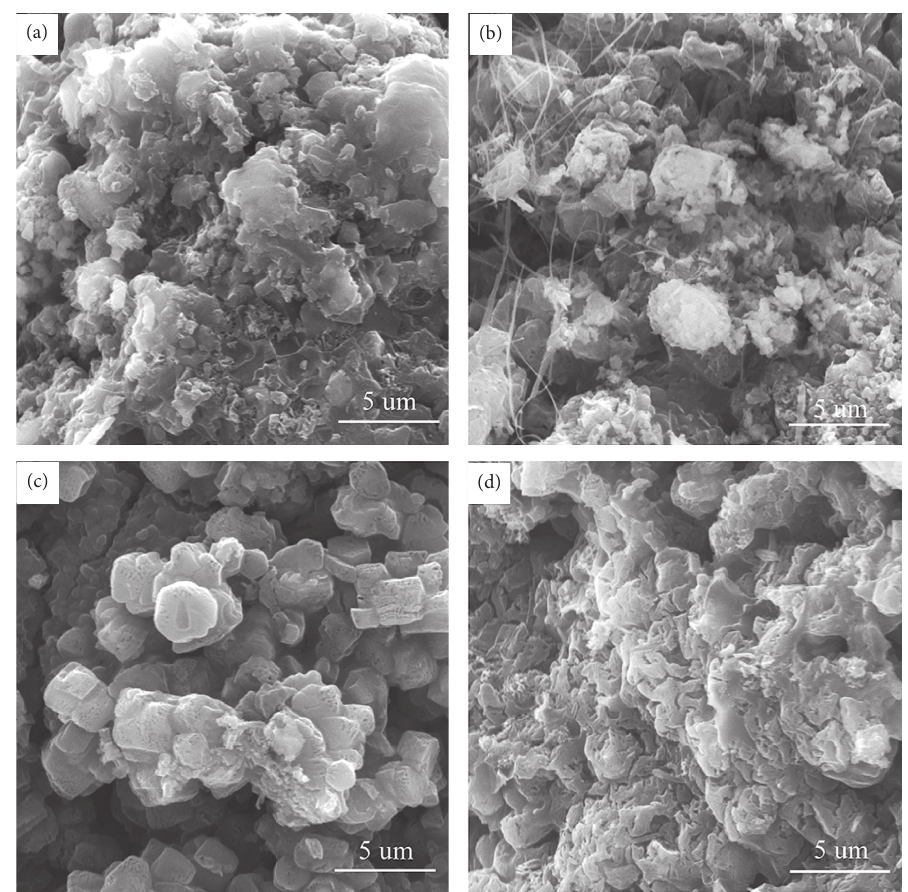
Figure 4: Effect of EDTA-Na